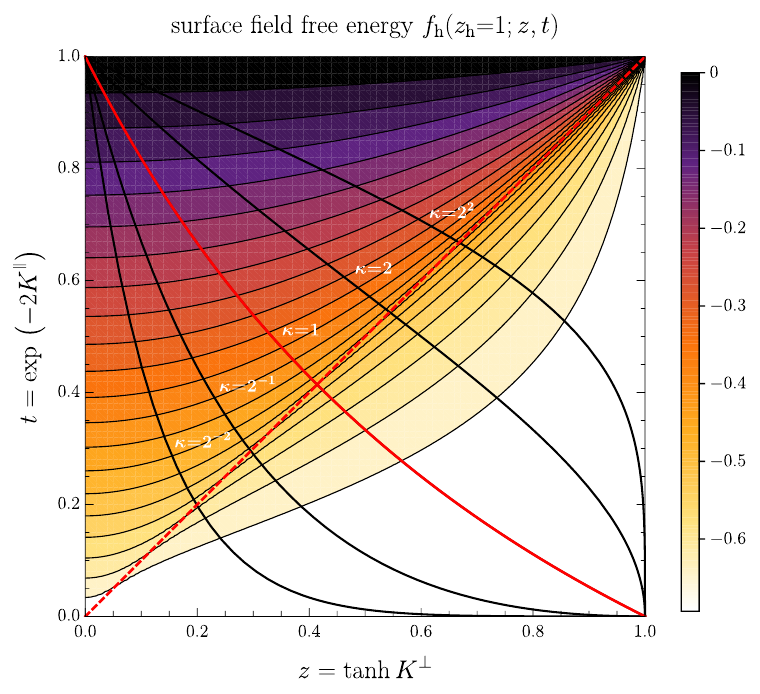
( z = 1; z , t ) , see (3.12). The dashed h h